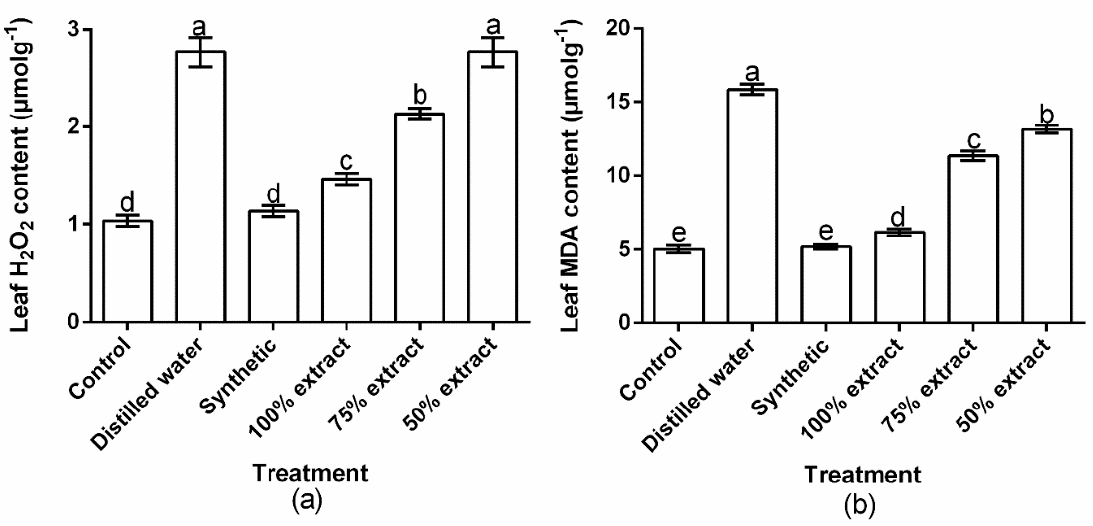
Figure 7. The effect of potato leaf extract on ( a ) leaf hydrogen peroxide (H 2 O 2 ) content and ( b ) leaf malondialdehyde (MDA) content. Data represent the mean ± standard deviation of three replicates. Lowercase letters indicate means that are significantly different according to the LSD test ( p < 0.05). Note: synthetic pesticide (recommended rate of Beta cypermethrin).